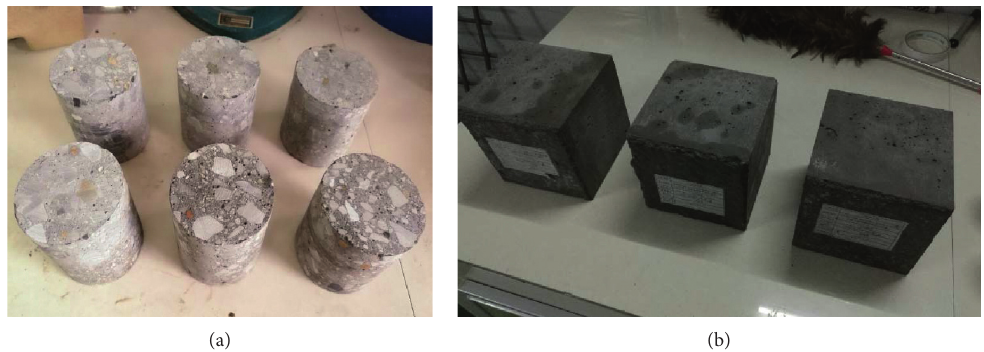
Figure 6: Core and cube samples for compression testing. (a) Core specimen. (b) Standard-maintained specimens.